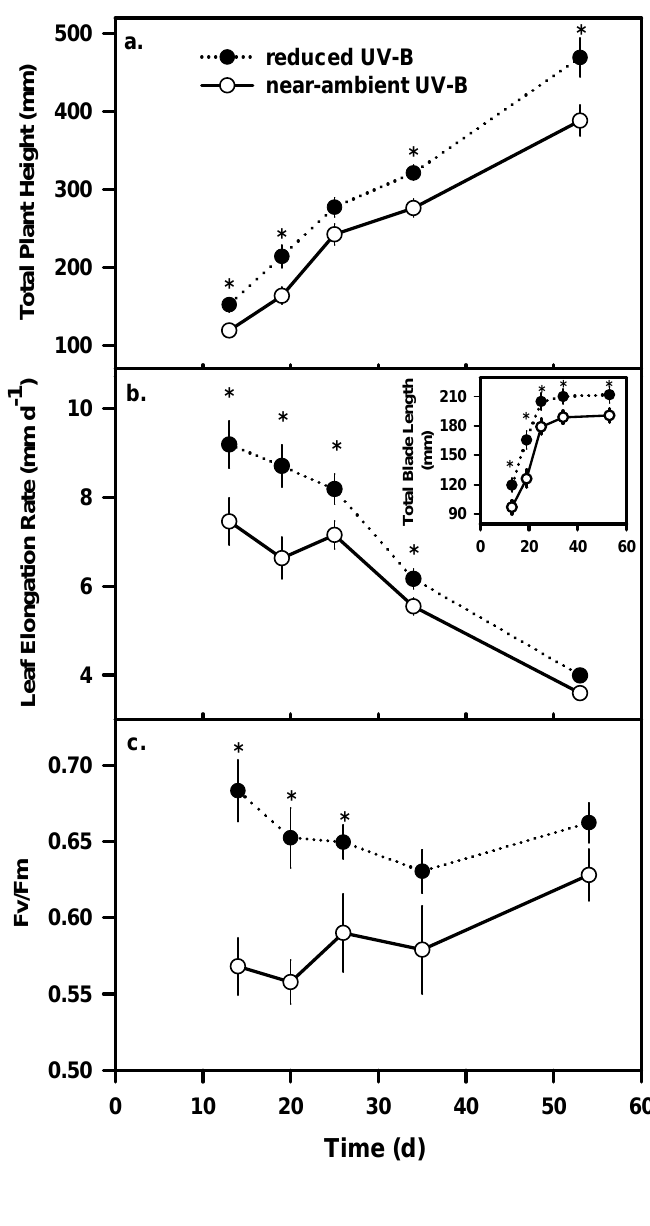
Figure 2. Average (a) total plant height, (b) leaf elongation rate and (c) maximum photochemical efficiency of photosystem II (F experiment. The inset in (b) shows the total blade length of marked leaves. Values are means of individual plants (n=10). Vertical bars denote ±1 SE and * indicates a significant UV-B treatment effect ( P ≤